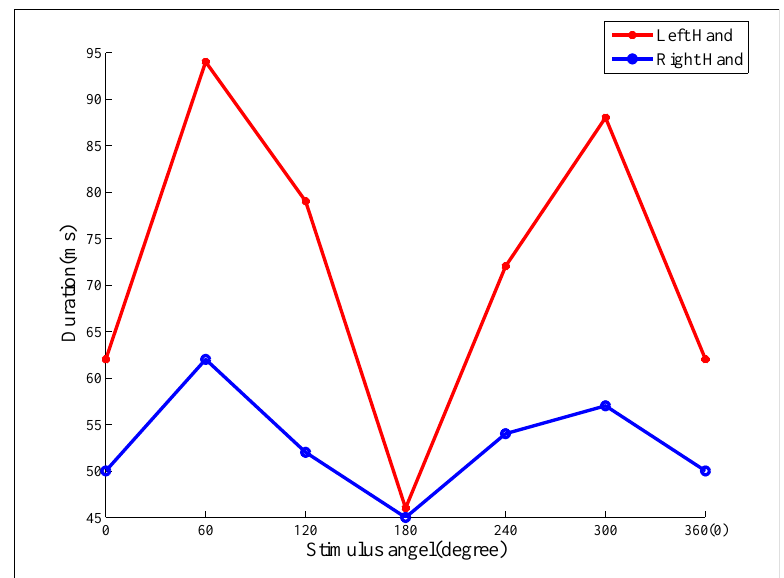
Figure 5. The duration of the second microstates mode A. The duration had a significant “angle effect”: shorter duration in cases of 0 ◦ (S1, S7) and 180 ◦ (S4, S10) for both the left- and the right-hand stimuli, and longer duration in the case of stimuli with left-hand pictures compared with that of stimuli with right-hand pictures at the same rotated